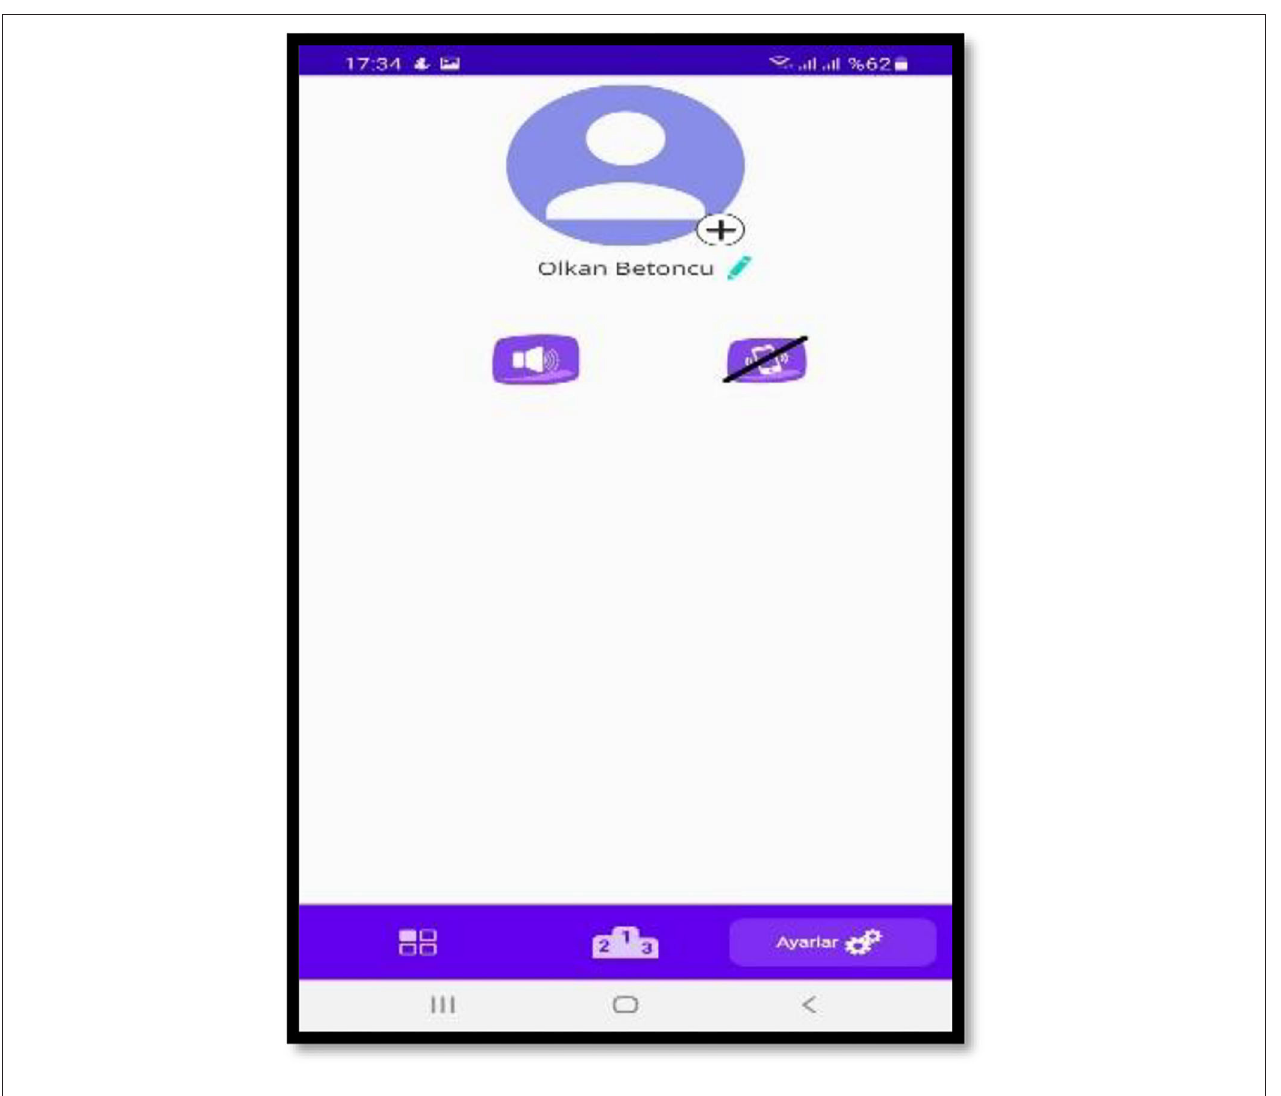
FIGURE 4 | Settings